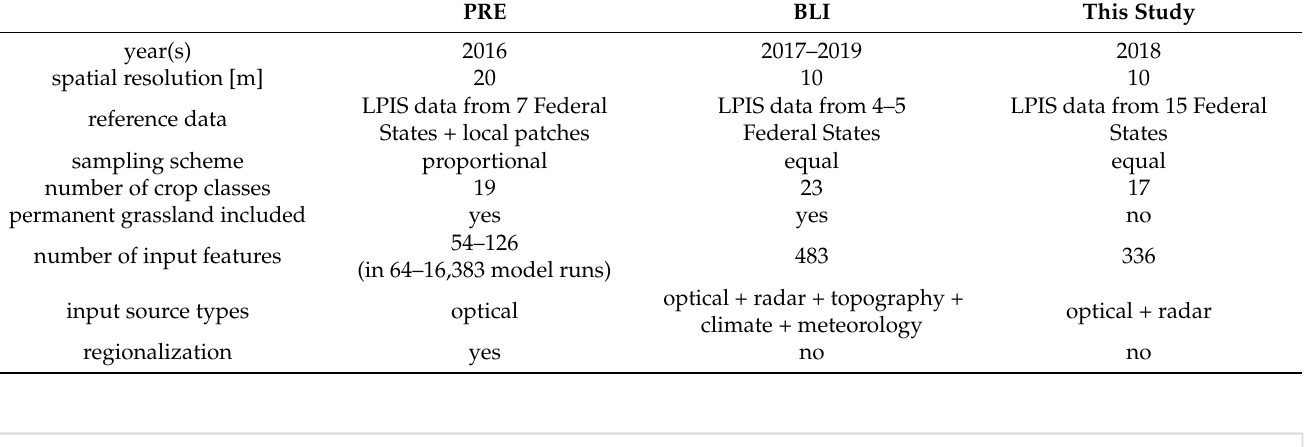
Table 4. Overview on crop type classification settings of the investigated studies Preidl et al. [22] (PRE), Blickensdörfer et al. [56] (BLI), and this study.